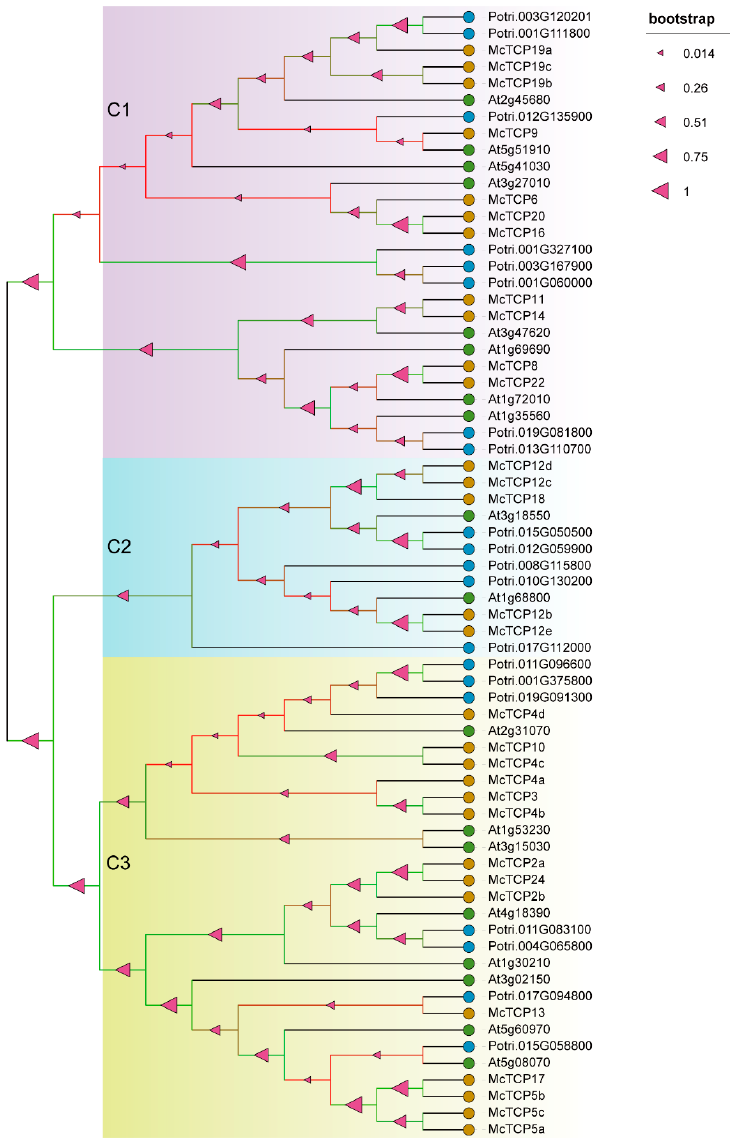
Figure 9. Phylogenetic evolution of TCP family members in three species. Different color models represent different clades. The pink triangle represents the bootstrap value, and the size of the triangle is in proportion to the bootstrap value. Before the gene name, blue dots represent P . trichocarpa , brown dots represent M . candidum , sapphire blue dots represent A . thaliana .